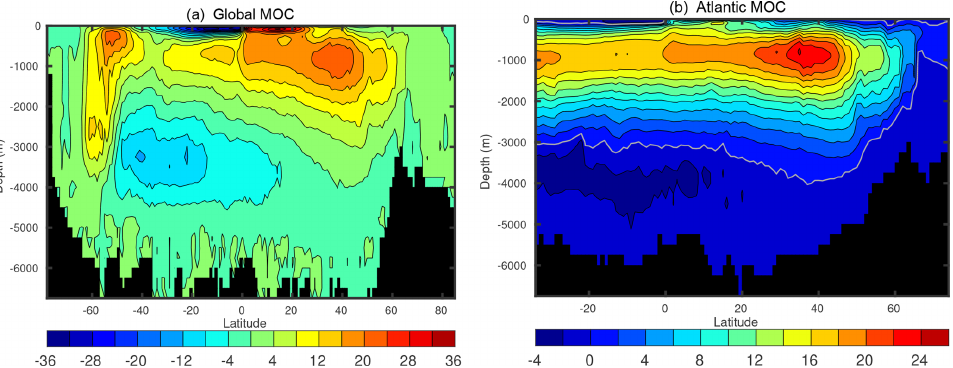
Figure 4. Averaged stream functions (Sv) of the (a) global meridional overturning circulation (MOC) and (b) AMOC in depth space in the PI control run.